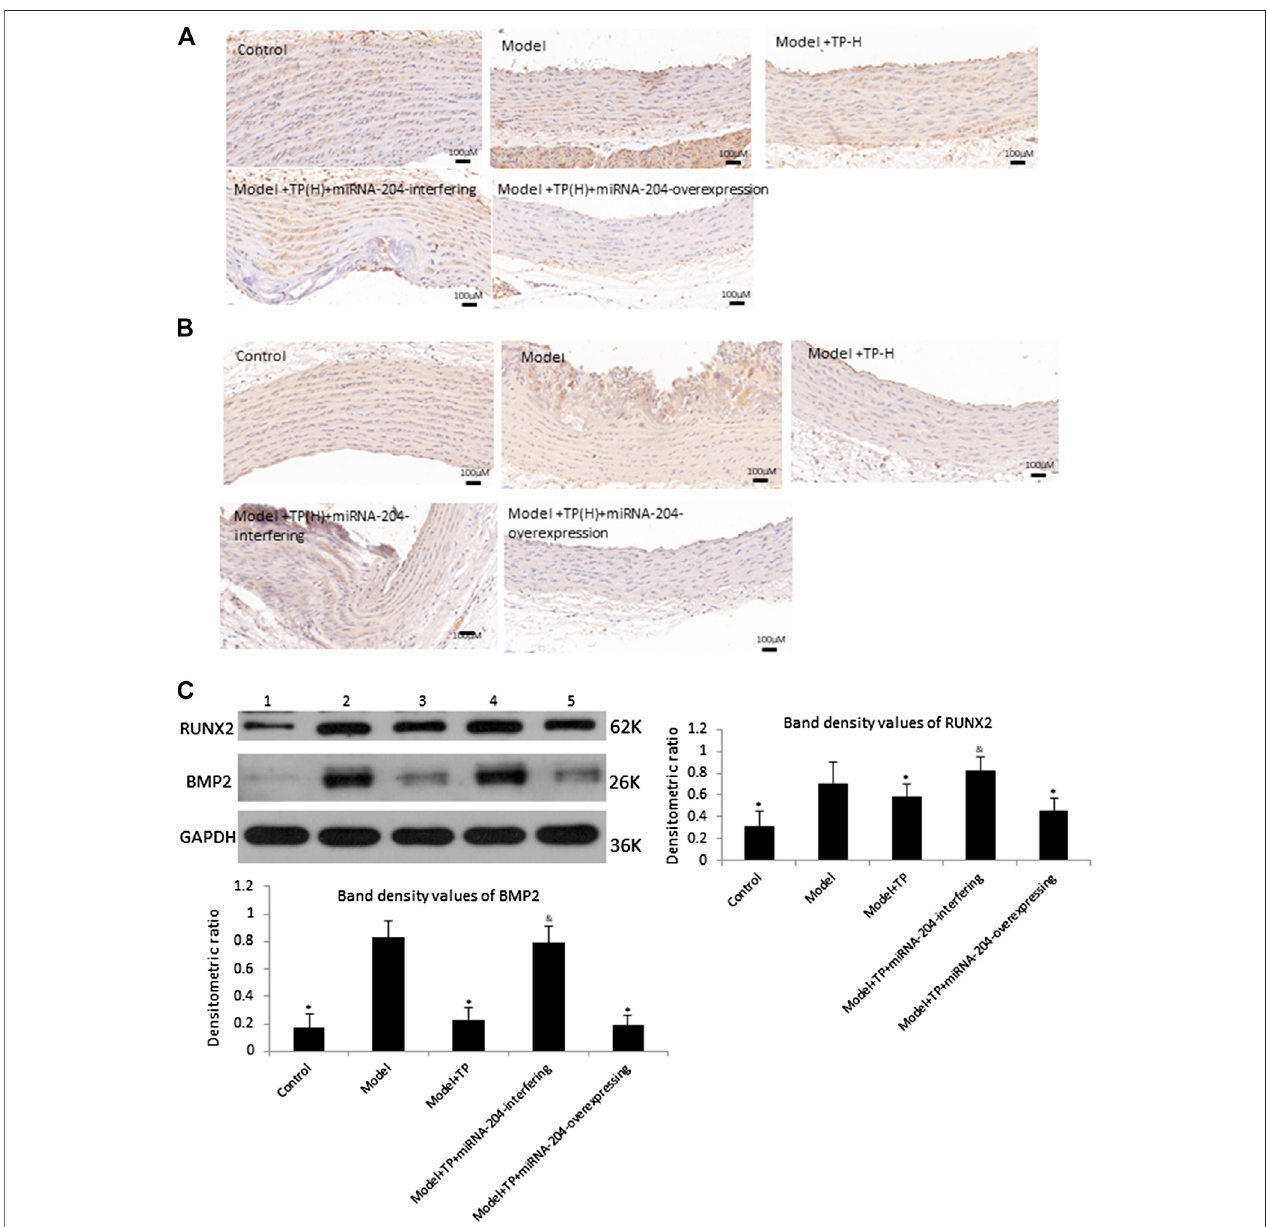
FIGURE 5 | TP reduces BMP2 and RNUX2 expression in a miRNA-204 increasing manner (A) Immunohistochemical staining of BMP2 (B) Immunohistochemical stainingofRUNX2 (C) WesternblotanalysisofBMP2andRUNX2(lane1:Control,lane2:Model,lane3:Model+TP,lane4:Model+TP+miRNA-204-interfering,lane5: Model + TP + miRNA-204-overexpression). Upper and left: representative images of BMP2 and RUNX2 expression, an antibody for DAPDH was used to show equal protein loading; under and right: bar graphs show quantitative evaluation of BMP2 and RUNX2 expression (n (cid:2) 3). Data are reported as the mean ± S.D. * p < 0.05 compared with model group; & p < 0.05 compared with model + TP